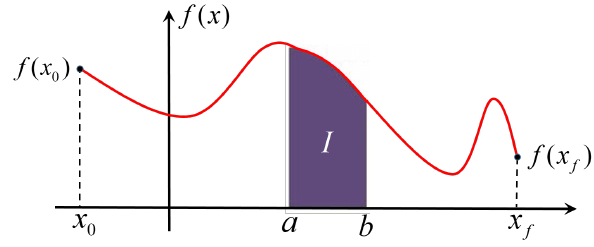
Figure 1. Integral and linear constraints